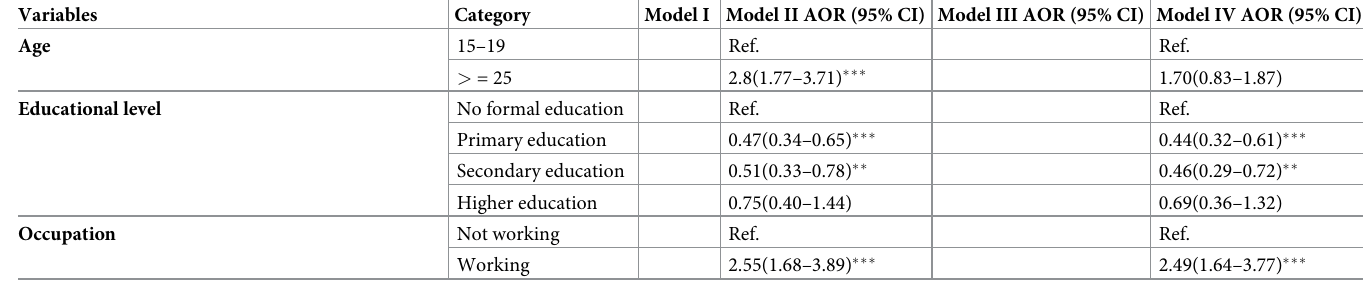
Table 3. A multivariable multilevel analysis of factors associated with risky sexual behavior among men in Ethiopia, 2016.